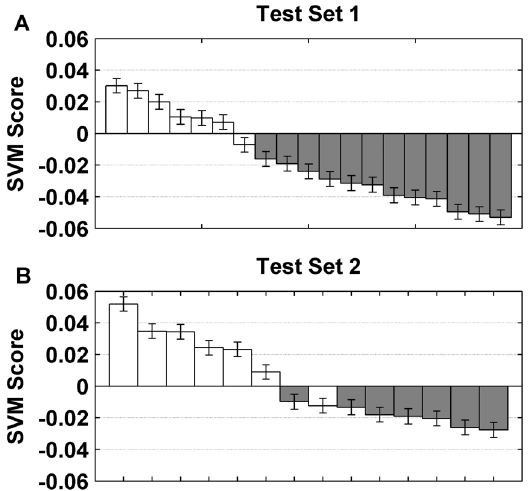
Figure 2. Performance of SVM signature in the testing sets. The classification scores assigned by the SVM based on the 251-gene signature to classify active TB (positive score) and controls (negative scores) in the absence of an HIV infection for A) Test Set 1 classifying TB patients after 2 months of treatment (white) and controls (grey), and B) Test Set 2 classifying TB active patients before treatment (white) and after 12 months of treatment (grey). doi:10.1371/journal.pone.0089925.g002 PLOS ONE |